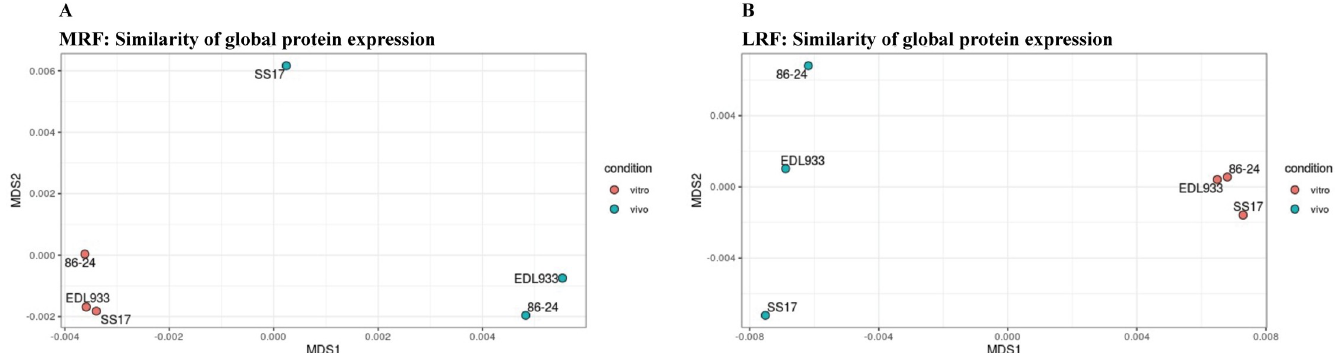
Fig 5. Multidimensional scaling plots generated with data from iTRAQ analysis #2 (reference-free). The plots depicting the similarity of global protein expression between O157 strains tested in (A) MRF or (B) LRF, in vitro and in vivo . This is based on Bray-Curtis dissimilarities generated from Scaffold normalized iTRAQ reporter intensities generated in reference-free iTRAQ analysis